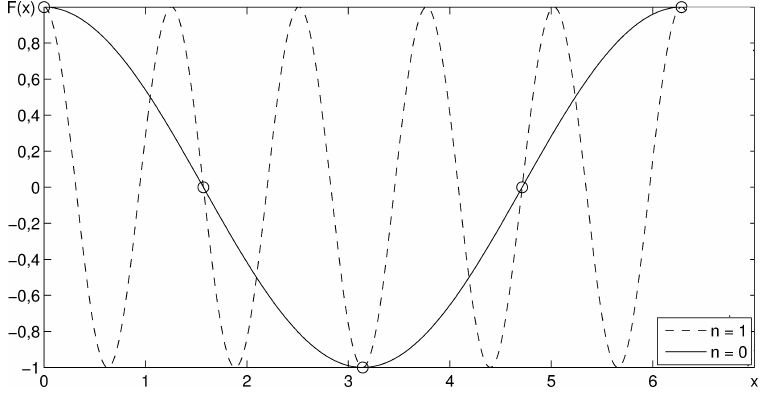
Fig. 2. Graphs of f .x;n; (cid:0) n/ at n D 0 (the solid line) and n D 1 (the dashed line); circles denote nodes of the equispaced